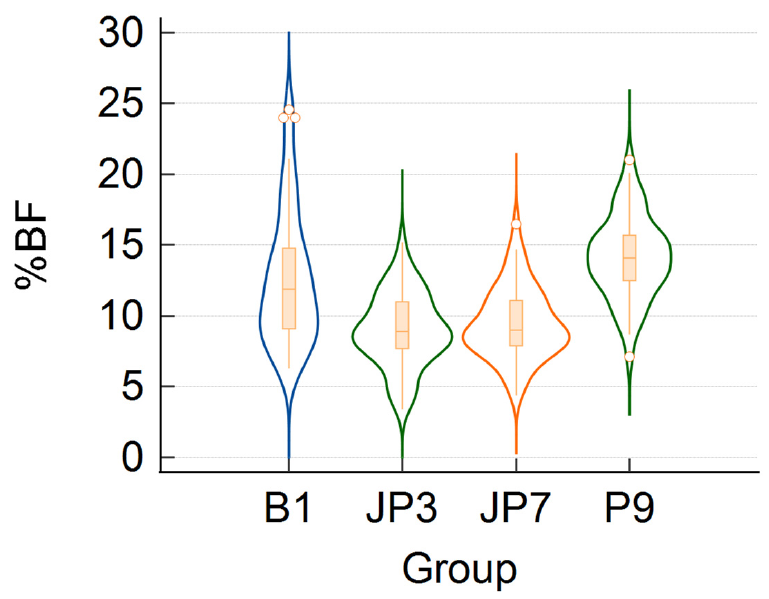
Figure 2. Violin plots of %BF values of the investigated group of 54 soccer players, obtained using A-mode ultrasound measurements of the subcutaneous fat thickness at certain anatomical sites and the B1, JP3, JP7, and P9 formulas (acronyms are explained in the caption of Figure 1). The width of the violin plot at a given %BF value tells how frequently it is encountered in the data set (wider regions correspond to more frequently occurring values).